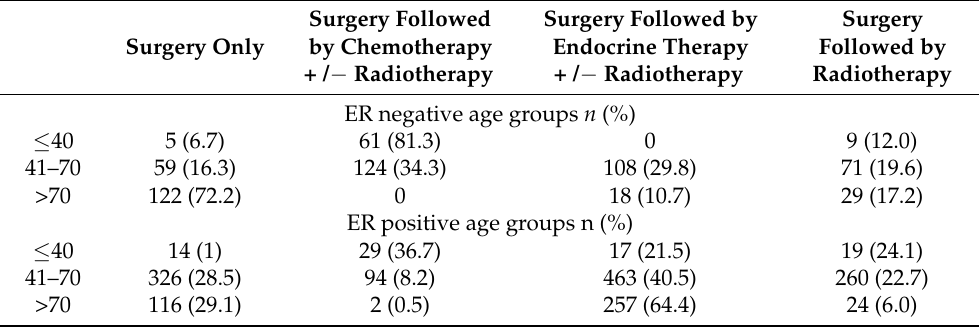
Table 3. Pattern of treatment of early operable primary breast cancer—comparison among age groups based on oestrogen receptor